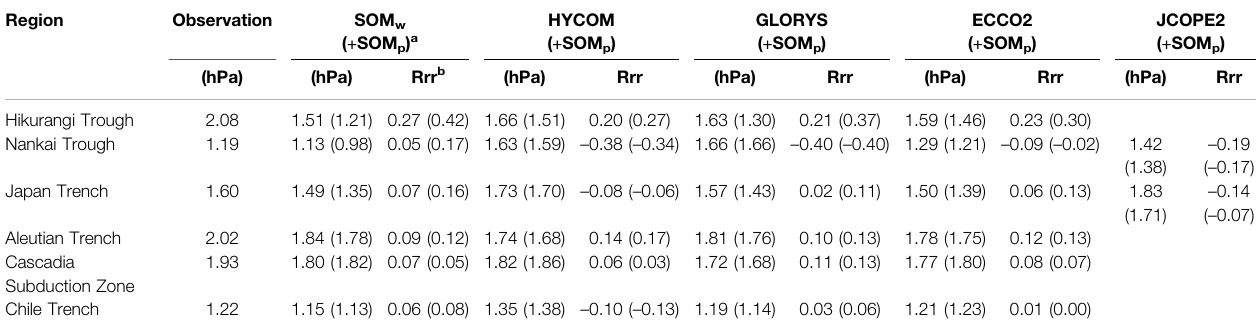
TABLE 3 | RMS amplitudes of observations and residual OBP with RMS reduction rate ( Eq. 5 ) using respective ocean models. Region Observation SOM w